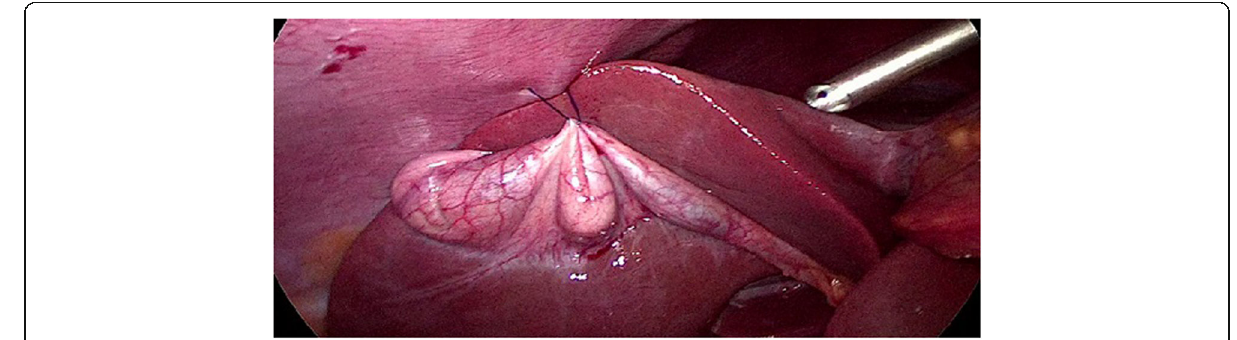
Fig. 3 Percutaneous suture was passed to be stitched to the gallbladder (body/Hartman and